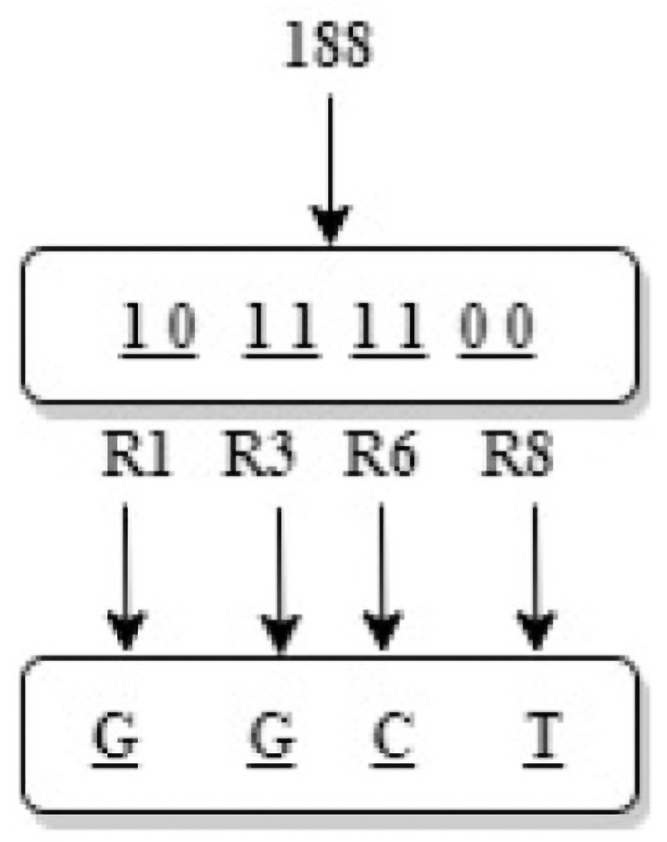
Fig 5. Bit-level dynamic DNA coding process